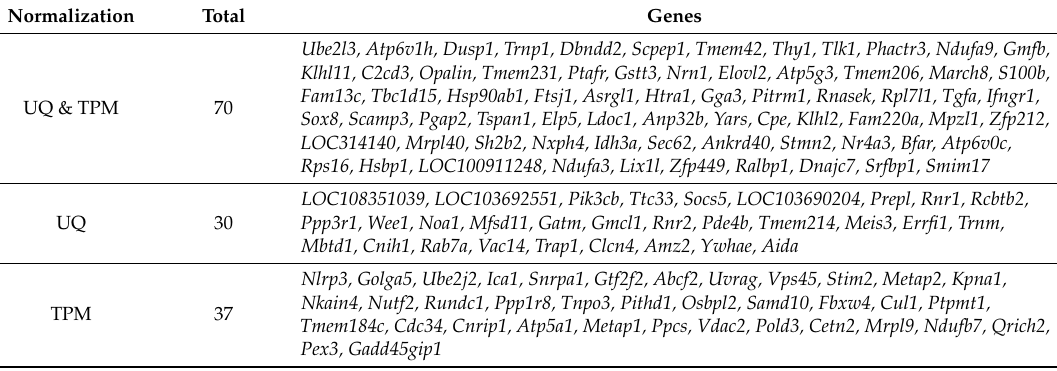
Figure 3. Venn diagram comparison of differentially expressed genes identified with NGS using separate data normalizations. The light pink circle represents the number of genes that were exclusively identified using TPM normalization, while the blue circle represents the number of genes that were exclusively identified using UQ scaling normalization. The dark pink oval represents the genes that overlapped between the TPM and UQ scaling normalizations. Table 4. Differentially Expressed Genes Identified Specific to Data